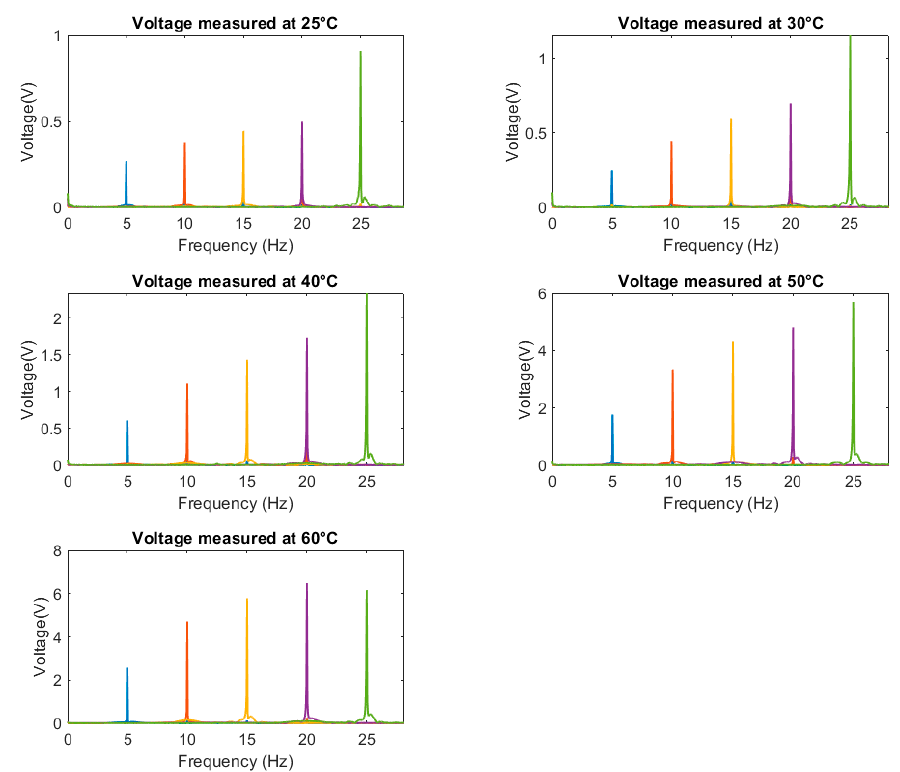
Figure 5. Frequency domain voltage measurement at various temperatures.